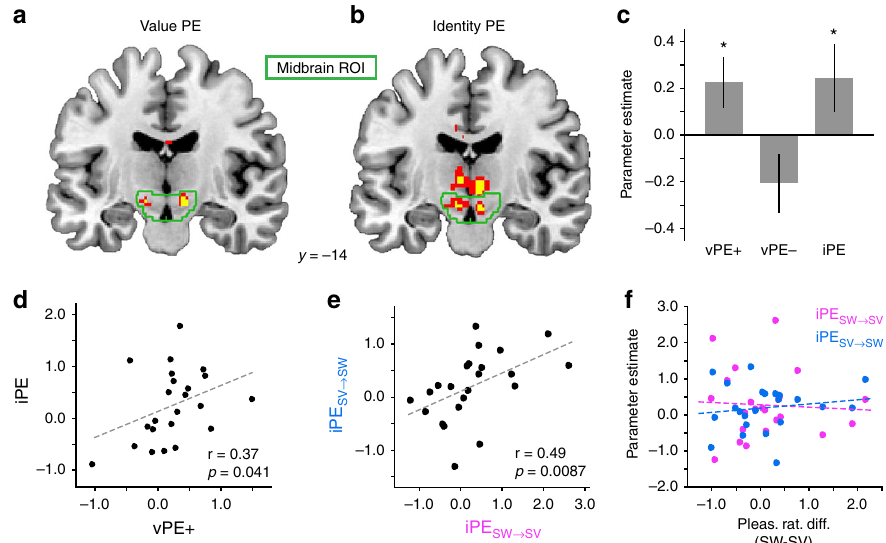
Fig. 3 fMRI activity related to iPE and vPE in the midbrain. a Positive value prediction errors (PE) evoked fMRI activity in the midbrain. b Identity PE evoked fMRI activity in the midbrain. In a and b , red = p < 0.005, uncorrected; yellow = p < 0.001, uncorrected. c Activity averaged across voxels in the midbrain region of interested (ROI) was signi fi cant for both iPE and vPE + . Error bars depict within-subjects s.e.m. * p < 0.05, post hoc t -tests vs. zero. d Midbrain responses to vPE + and iPE were correlated across participants. e Midbrain responses to the two possible types of identity reversals, iPE SW → SV and iPE SV → SW , were correlated across participants. f Differences in pleasantness ratings between SW and SV odors were not correlated with midbrain fMRI activity related to iPE SW → SV or iPE SV → SW